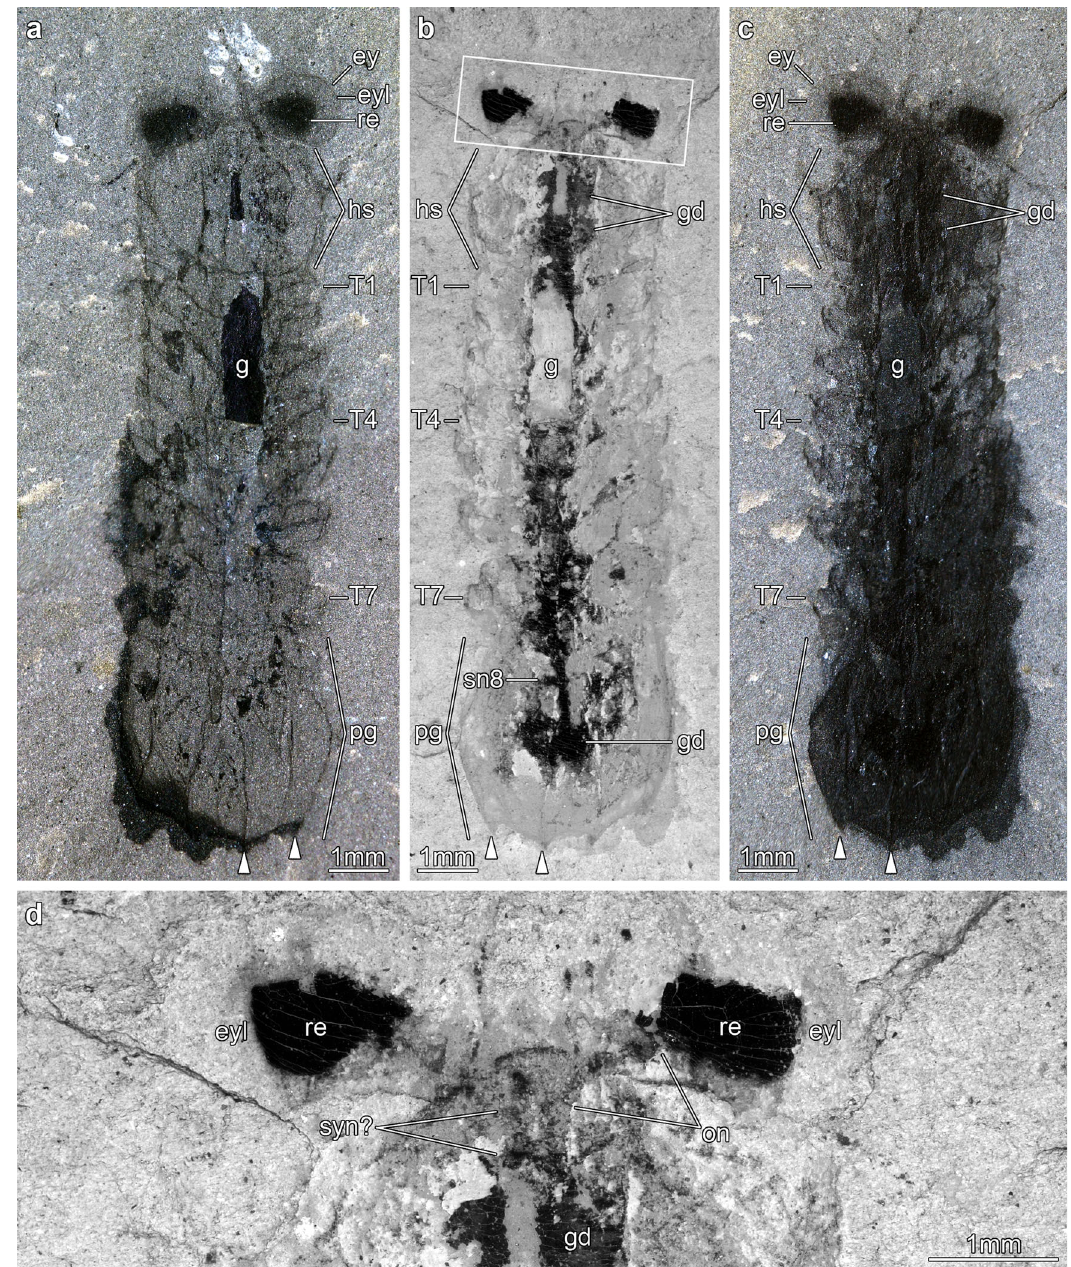
Fig. 1 Central nervous system preservation in Mollisonia symmetrica from the Cambrian (Wuliuan) Burgess Shale, Raymond Quarry. a MCZ 1811a, photographed underwater with cross-polarized illumination; arrowheads indicate position of spines in pygidium. b MCZ 1811b, imaged with backscattered electron microscopy. c MCZ 1811b, photographed underwater with cross-polarized illumination. d Magni fi cation of head region in MCZ 1811b using backscattered electron microscopy. ey lateral eye, eyl eye lens, g gut tract, gd gut diverticulum, hs head shield, on optic nerve, pg pygidium, re retina, sn8 segmental nerve 8, syn? putative synganglion, T n trunk